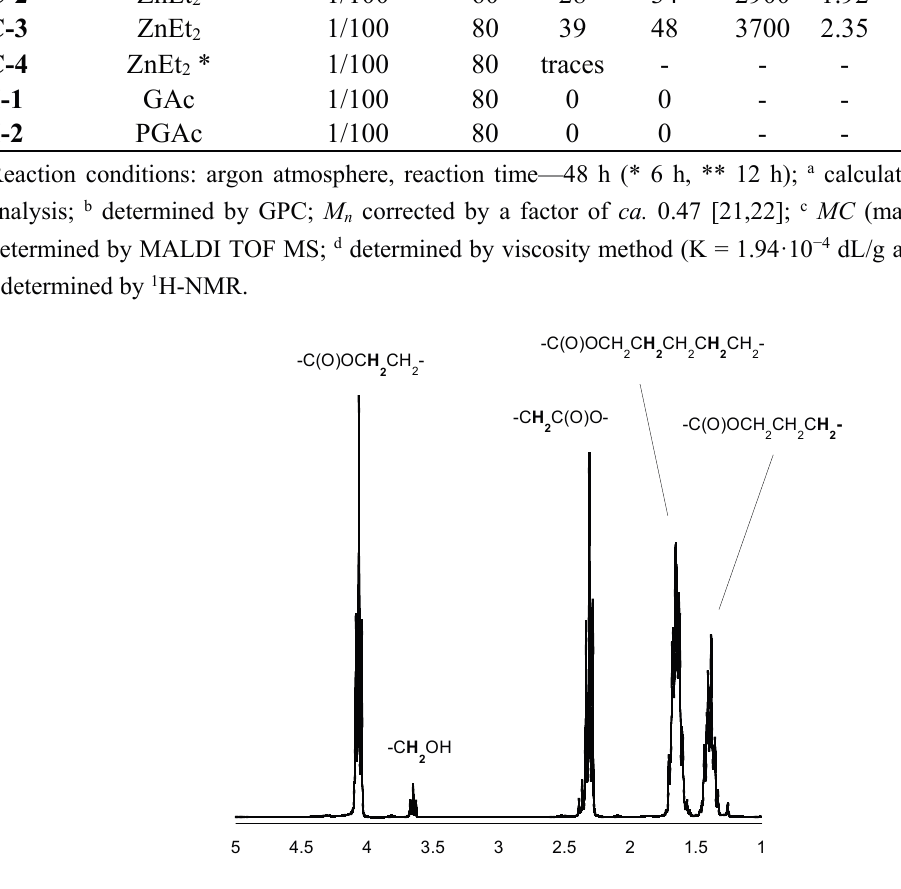
Figure 2. 1 H-NMR spectrum of the PCL (in CDCl 3